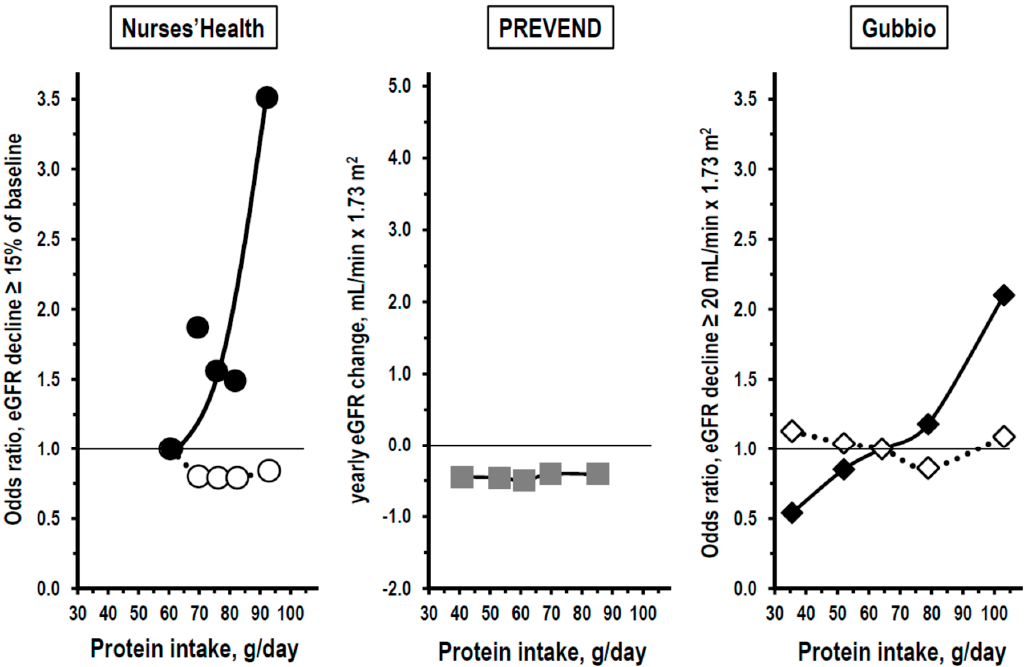
Figure 2. Relationships of baseline protein intake to kidney function decline in multivariate quintile analyses of the Nurses’ Health study, the Prevention of Renal and Vascular End-stage Disease (PREVEND) study, and the Gubbio study. Protein intake was assessed by a questionnaire in the Nurses’ Health study and by urine urea nitrogen in the PREVEND study and in the Gubbio study. Kidney function was assessed as estimated glomerular filtration rate (eGFR) in all studies. Outcomes of interest in vertical axis differed among the studies as follows: The Nurses’ Health study targeted the incidence at the second visit of eGFR decline ≥ 15% of baseline eGFR (left panel, vertical axis = odds ratio versus quintile 1, thin horizontal line = quintile 1 as reference); the PREVEND study targeted the mean annual change in eGFR from first visit to second visit (central panel, thin horizontal line = no change in eGFR); the Gubbio study targeted the incidence of eGFR decline ≥ 20 mL/min × 1.73 m 2 below baseline eGFR (right panel, thin line = quintile 3 as reference). Open symbols are for the subgroup with non-reduced baseline eGFR ( ≥ 80 mL/min × 1.73 m 2 in the Nurses’ Health study and ≥ 90 mL/min × 1.73 m 2 in the Gubbio study); closed black symbols are for the subgroup with reduced baseline eGFR (<80 mL/min × 1.73 m 2 in the Nurses’ Health study and <90 mL/min × 1.73 m 2 in the Gubbio study); closed gray symbols are for data in the whole study cohort.